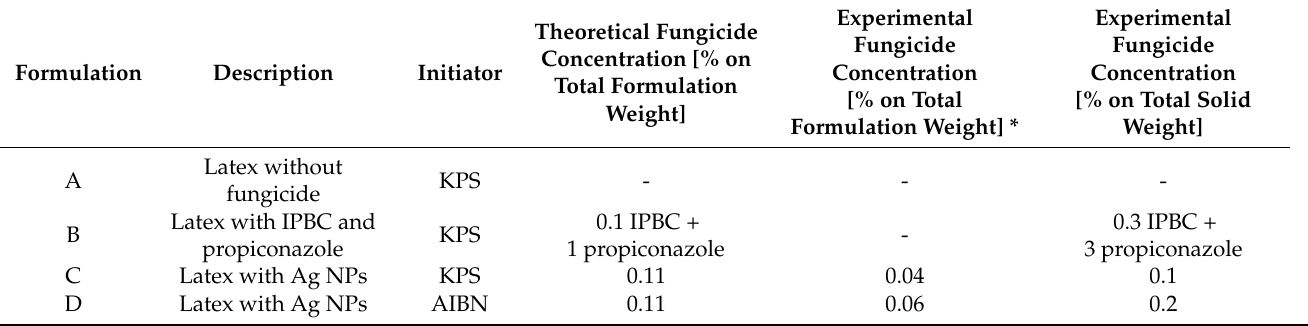
Table 1. Formulations prepared from latexes containing AgNPs mixed with a commercial acrylic resin, their identification, and fungicide